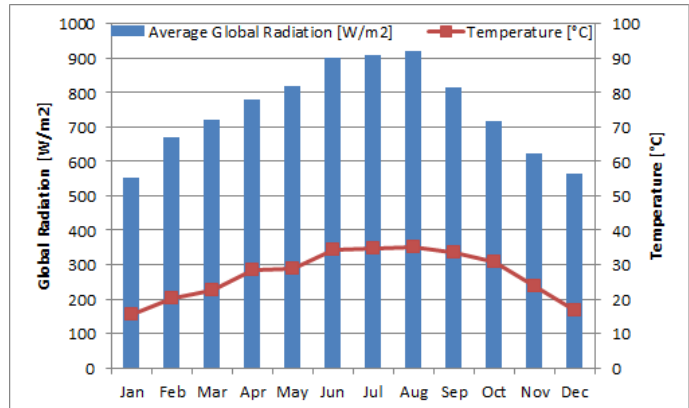
Figure 3. Average Global Radiation and Temperature in year